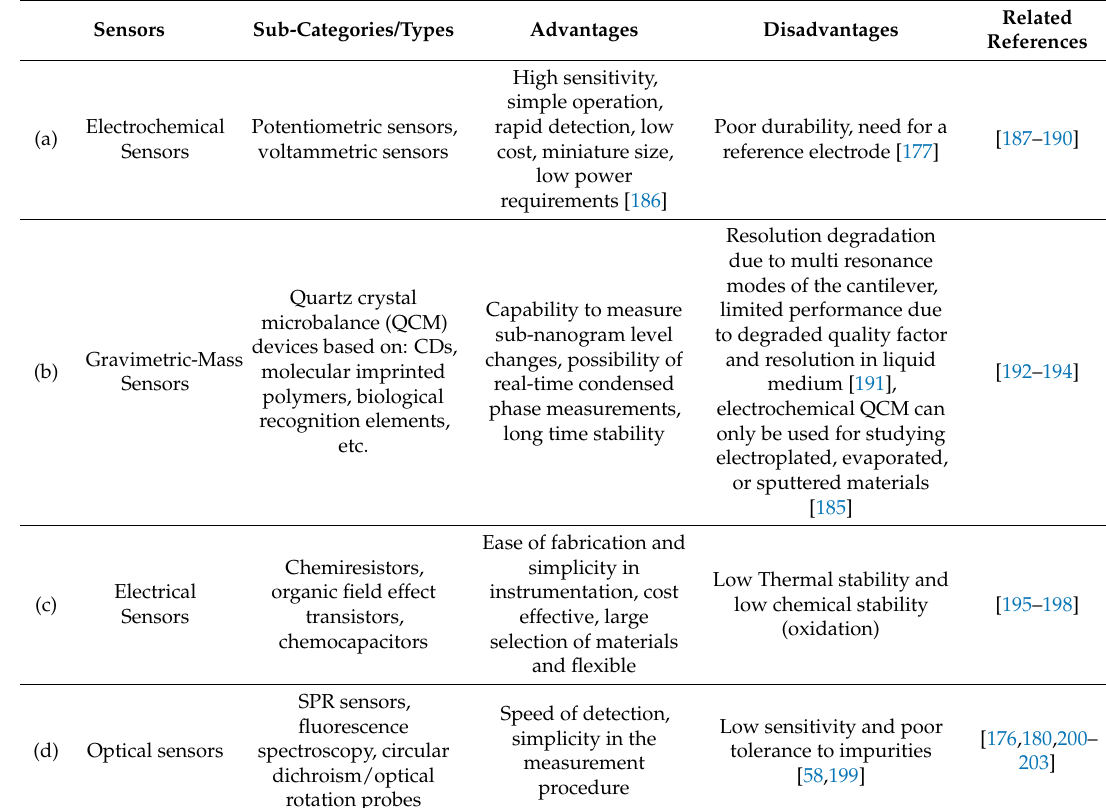
Table 3. Representative list of chiral sensing methods. The table derives from Manoli et al.